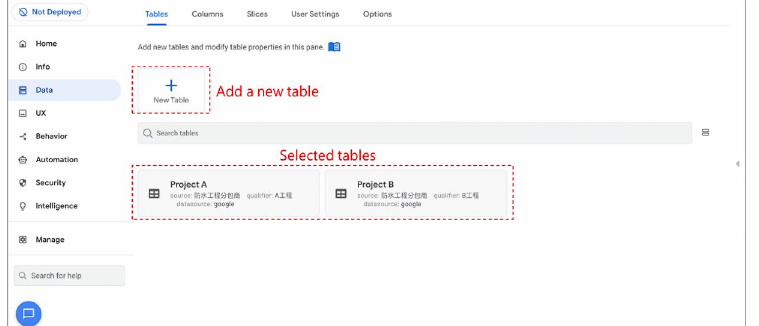
Figure 15. Table selection screen image